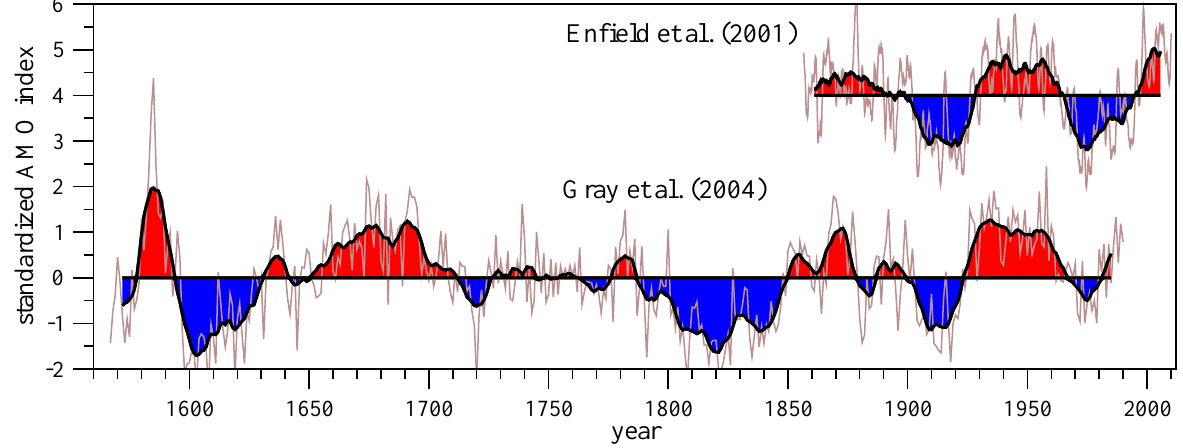
Fig. 2. Top: standardised annual mean SST anomaly and AMO series as in Fig. 1, shifted upward for a clear visualisation. Bottom: standardised annual mean SST anomaly (thin line) and its ten years running mean (thick line, red and blue coloured) determined from the tree ring proxy data set by Gray et al. (2004) ftp://ftp.ncdc.noaa.gov/pub/data/paleo/. M. Vincze and I. M. J´anosi: Is AMO a statistical phantom? 3